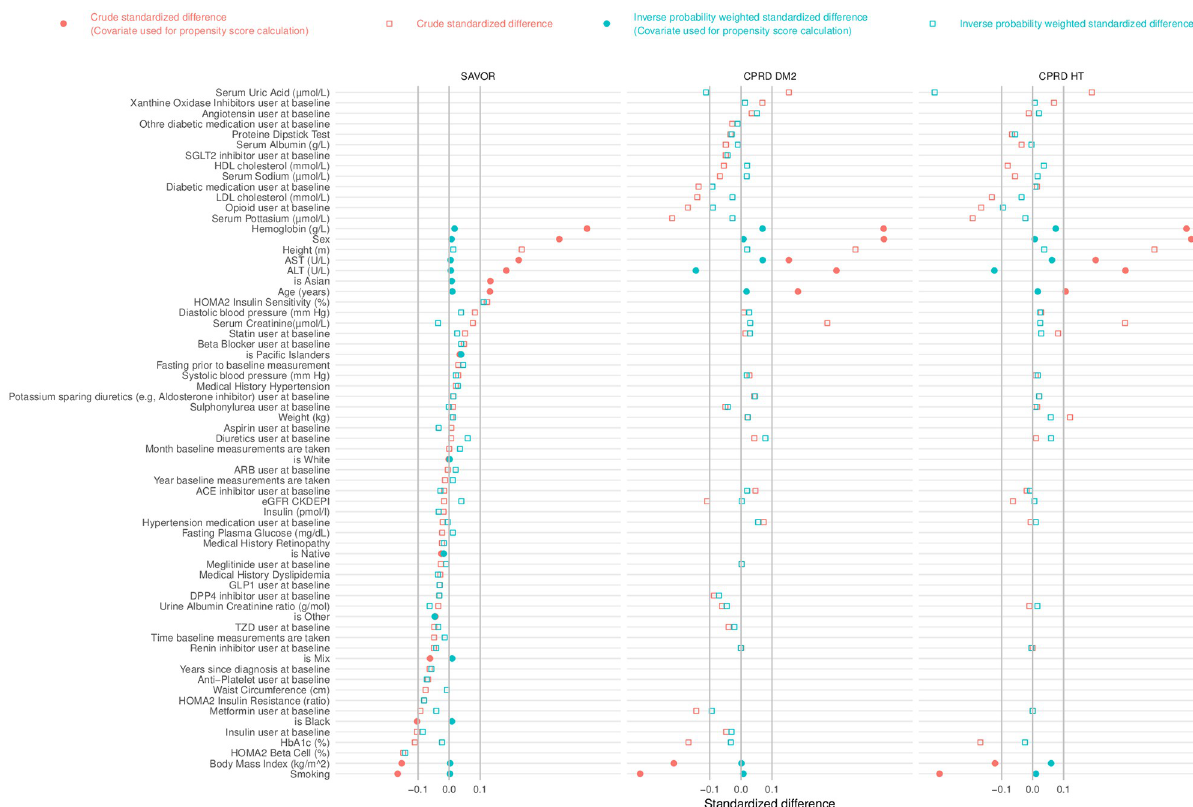
Fig 4. Standardized difference plot for each cohort with and without inverse probability weighting. Red dots and squares are the crude standardized difference of the patient subpopulation with high bilirubin (patients with greater than or equal to median baseline serum bilirubin value) against low bilirubin. Positive standardized difference indicates positive correlation between high bilirubin and the baseline characteristic listed in y- axis. We consider absolute standardized difference over 10% to be significantly different baseline characteristic between the high bilirubin group and low bilirubin group. Green dots and squares are the standardized difference after inverse probability weighting. Filled squares indicates these covariates (Sex, ALT, AST, Race, Age, Body Mass Index, Smoking) are used to calculate the propensity score for the inverse probability weighting. After the inverse probability weighting the difference of baseline characteristics between high bilirubin and low bilirubin subpopulations become not significant except HOMA2 Beta Cell, HOMA2 Insulin Sensitivity (for SAVOR), Serum Uric Acid and ALT (for CPRD cohorts). We note that the proportion of missing baseline records for HOMA2 Beta Cell, HOMA2 Insulin Sensitivity (for SAVOR), Serum Uric Acid and ALT (for CPRD-DM2) are 56%, 56%, 93%, 85%, respectively. Protein Dipstick Test results are converted in to the numerical values in the order of null, trace, +, ++ as 0,1,2,3 respectively. Sex is coded 0 as female and 1 as male. isAsian, isPacific Islander, isWhite, is Native, is Other, is Mix, is Black are the binary coding of the racial category of the patient, for example if the reported race of the patient is an Asian then 1 as isAsian variable and 0 for isPacific Islander, isWhite, isNative, isOther, isMix, and isBlack. Smoking is coded as a binary variable where 1 indicates the current smoker and 0 otherwise. Time baseline measurements are taken was recorded in 24 hr scale with minutes converted into fraction of an hour. Other diabetic medication is the medication included in the British National Formulary (BNF) code chapter ‘Other Antidiabetic